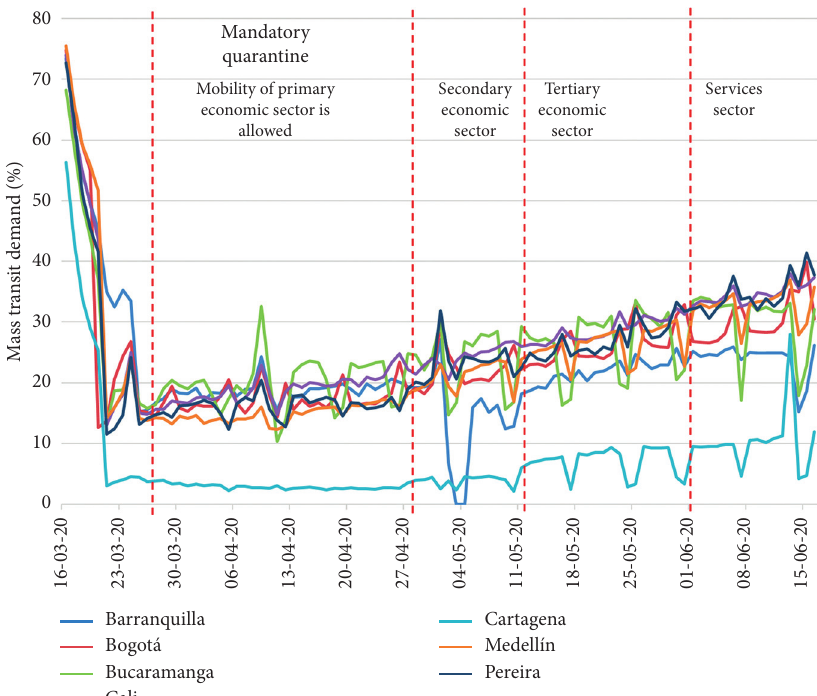
Figure 7: Public transport demand.